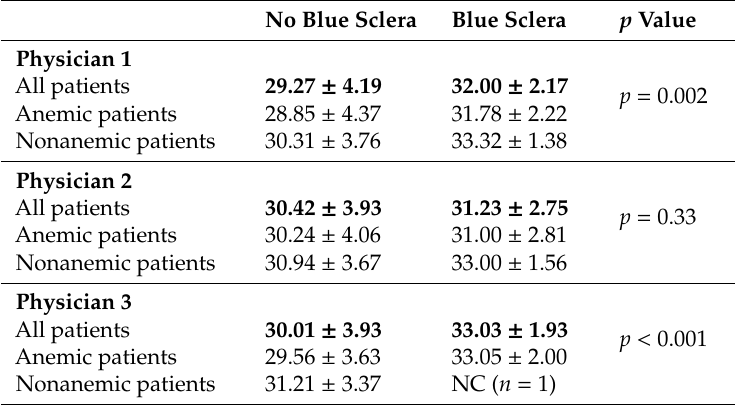
Table 3. Computed blue sclera assessment by the MS method by